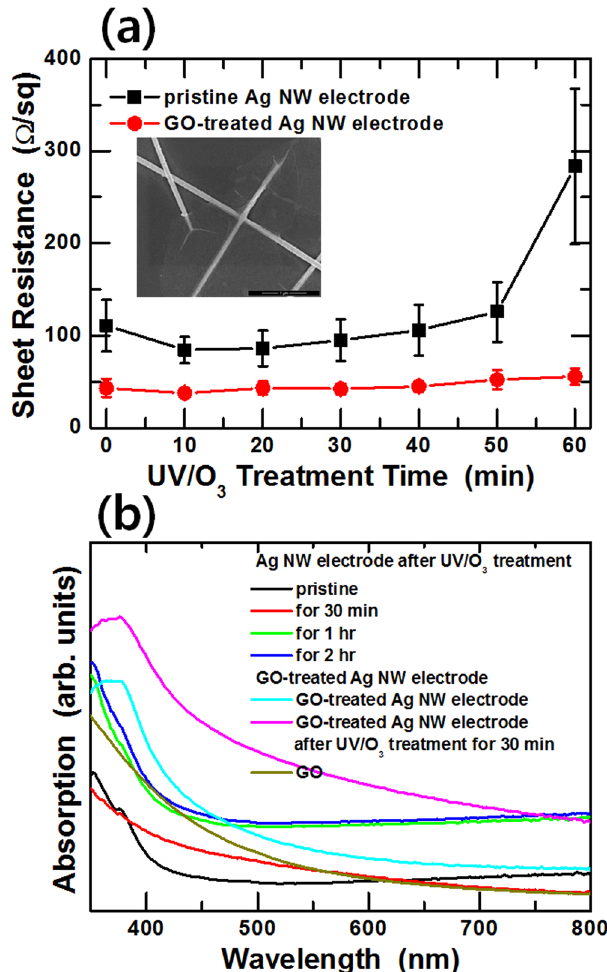
Figure 8. ( a ) Sheet resistance variations of the Ag NW electrodes with and without a GO treatment for various UV/O 3 treatment times. ( b ) Absorption spectra of the pristine Ag NWs, the Ag NWs after UV/O 3 treatment for various times, the graphene oxide (GO)-treated Ag NWs, and the GO-treated Ag NWs after UV/O 3 treatment for 30